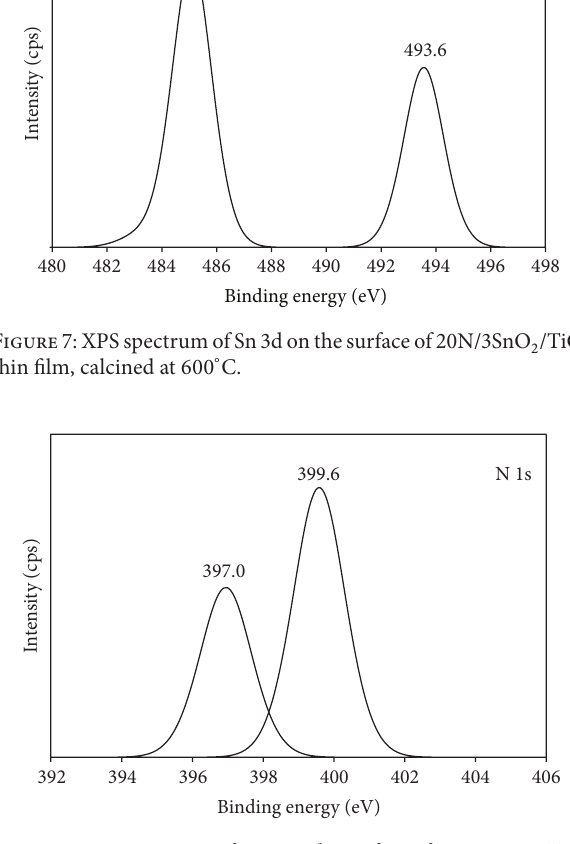
Figure 8: XPS spectrum of N 1s on the surface of 20N/3SnO 2 /TiO 2 thin film, calcined at 600 ∘